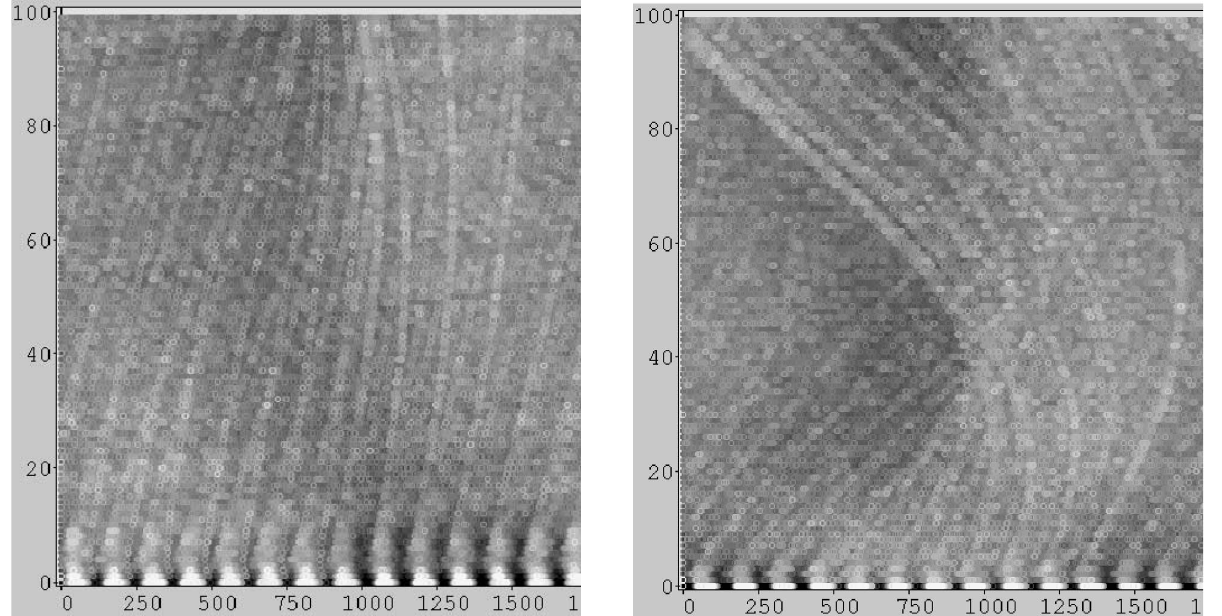
FIG. 8. Waterfall plots of line density. Left: one trace each 20 turns, span 3.3 ms. Right: one trace each 50 turns, span 8.3 ms; abscissa in nanoseconds. 3.0 3 10 12 protons.